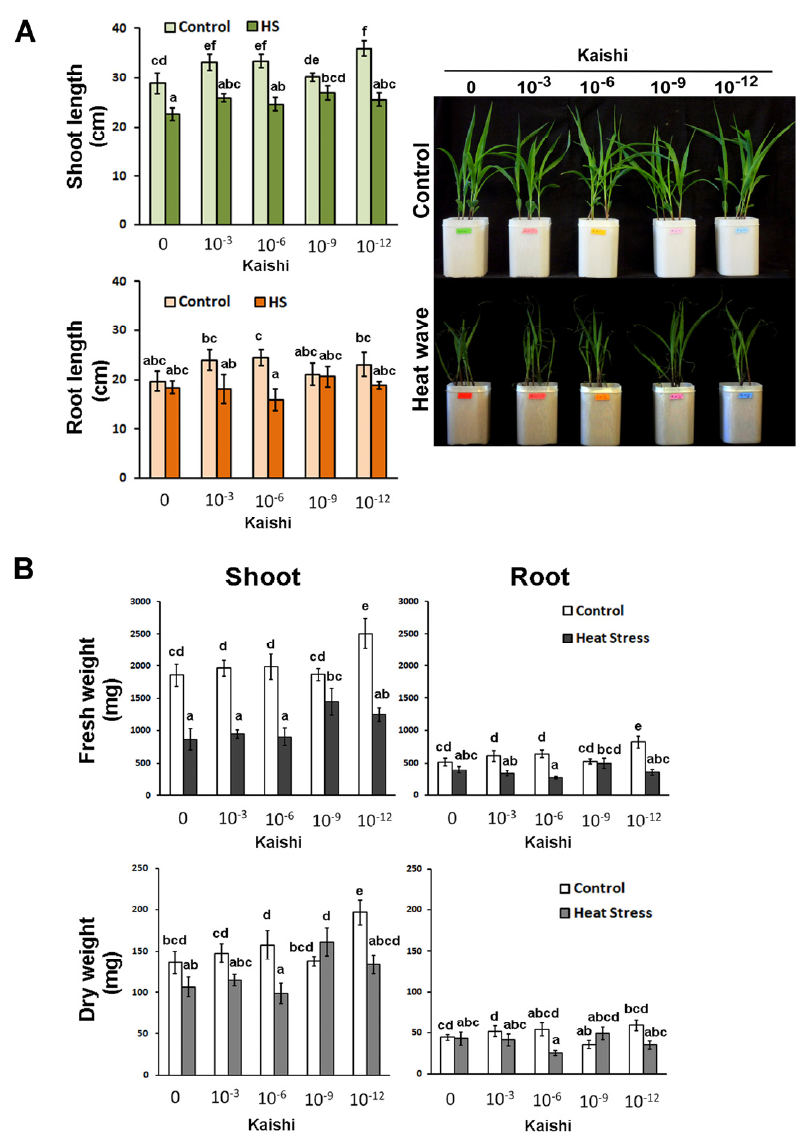
Figure 1. Effects of simulated heat wave on soil-grown maize plants treated with 10 − 3 , 10 − 6 , 10 − 9 , and 10 − 12 biostimulant solution via a foliar spray. ( A ) Shoot length, root length, and visible status; ( B ) FW and DW of shoots and roots of differently treated plants. Values are means ± SD ( n ≥ 15). The different lowercase letters indicate statistically significant differences at p < 0.05 (multifactor ANOVA).